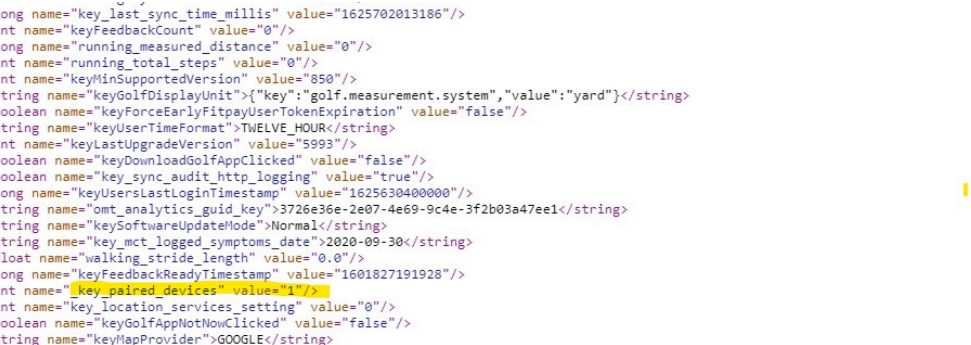
Figure 21. Number of Garmin devices paired with the Connect app.